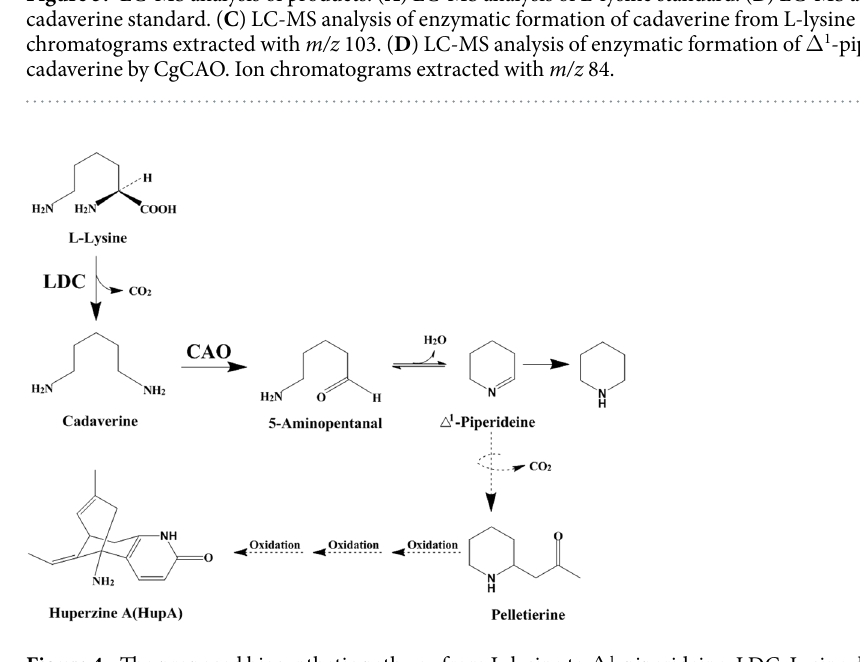
Figure 4. The proposed biosynthetic pathway from L-lysine to Δ 1 -piperideine. LDC: Lysine decarboxylase; CAO: Copper amine